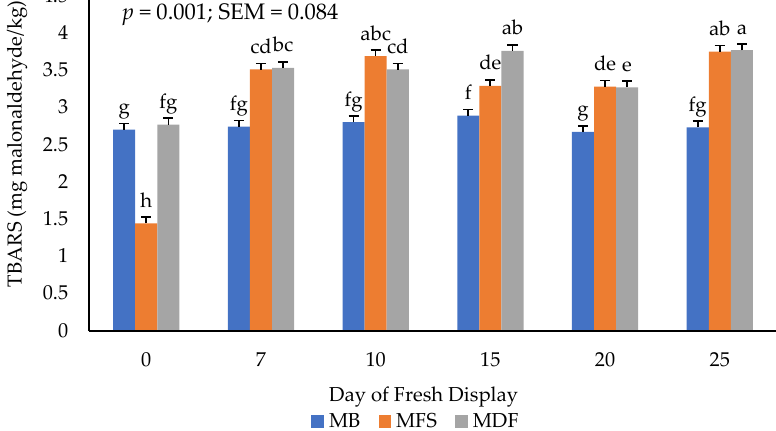
Figure 1. Interactive effect of treatment × day of display for 2-Thiobarbituric acid reactive substances (TBARS). a–h: Bars lacking common letters differ ( p ≤ 0.05).